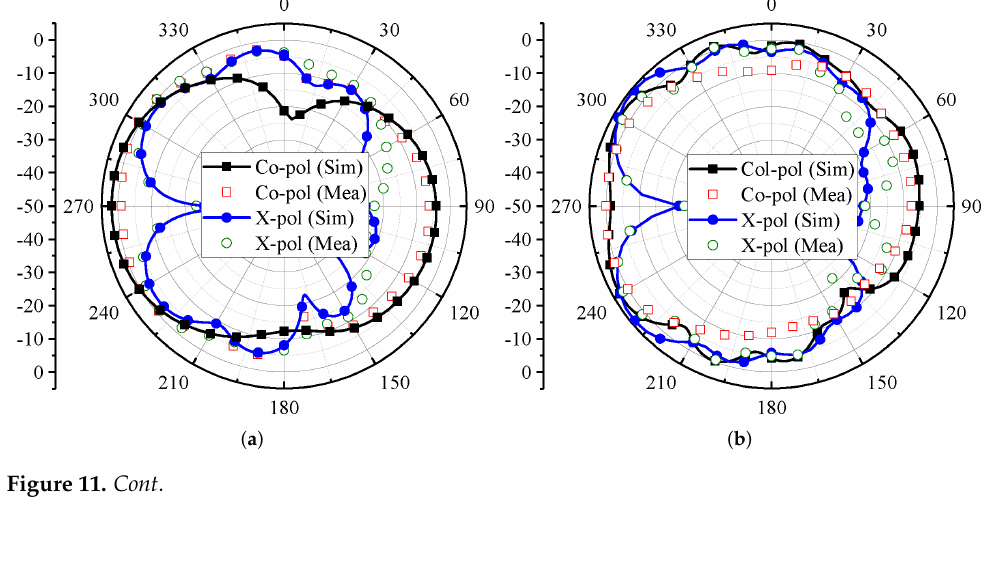
( d ) Figure 11. Modeled and actual radiation characteristics of MIMO antenna at ϕ = 90 ◦ for (a, b) Ant 1 at 3.4 GHz and 4.8 GHz, and (c, d) Ant 4 at 3.4 GHz and 4.8 GHz. ( a ) ( b ) Figure 12. (a) ECC and (b) ergodic CC of MIMO antenna. 5. User’s Effect on MIMO Antenna